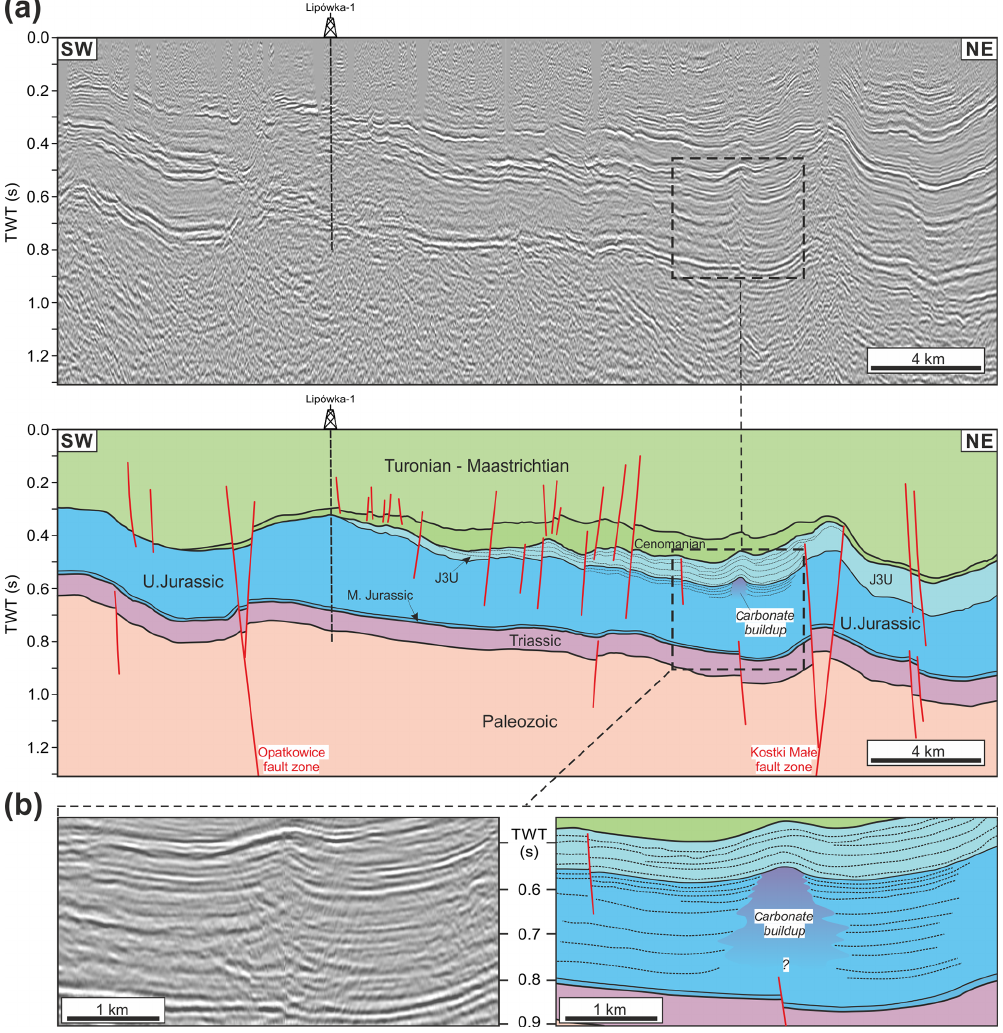
Figure 9. (a) Uninterpreted and interpreted seismic profile (11-5-92K) from the Miechów Trough (see Fig. 5 for location). Major NW– SE-oriented Opatkowice and Kostki Małe fault zones are rooted in the Palaeozoic basement and are associated with inversion anticlines developed within the Mesozoic cover. (b) One isolated carbonate buildup was identified in this